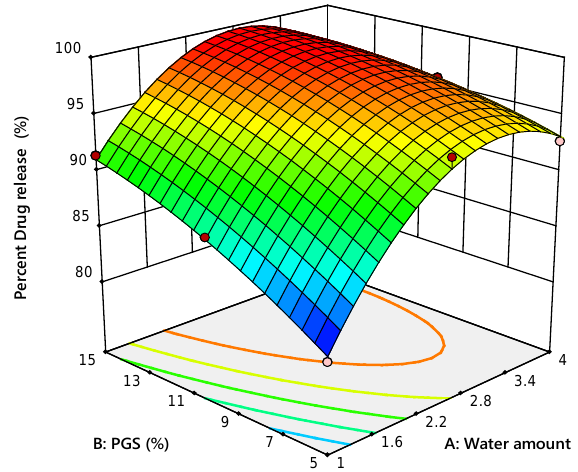
Figure 6. Response surface plot for the influence of water amount (X 1 ) and PGS amount (X 2 ) on percent release of metformin after 30 min.